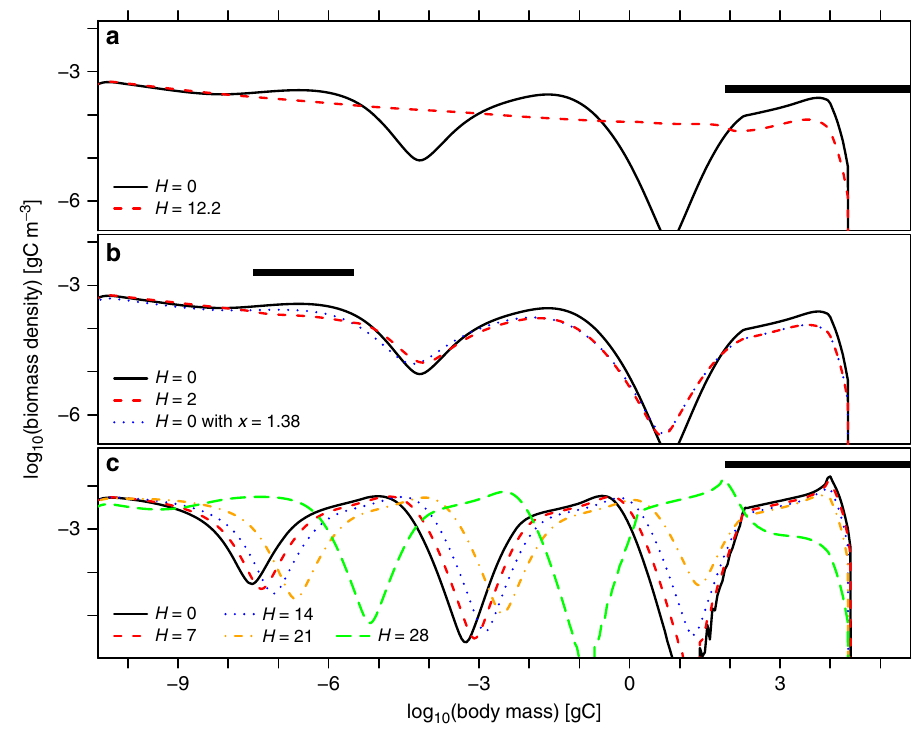
Fig. 2 Demonstration of top-down and bottom-up effects in SSSM simulations. Species with body mass at fi rst maturation m * in the ranges indicated by the horizontal bars (panels a , c m * ≥ 10 − 1.9 gC; panel b 10 − 7.5 gC ≤ m * ≤ 10 − 5.5 gC) are harvested at an allometrically scaled rate ( m * /gC) − 1/4 H with H as given in the legend. Panels a , b show community size spectra for moderate nutrient supply (eutrophication parameter x = 10 0.2 = 1.58). The dome structure can be top-down controlled ( a ) but not bottom-up controlled ( b ). In panel c , nutrient supply is higher ( x = 10) and dome size controlled through inherent non- linear regulation 72 rather than cascading pressures. Contrasting panel a , top-down forcing H in panel c therefore barely affects the height of the size- spectrum mode near 10 − 5 gC body mass; only the position of the mode